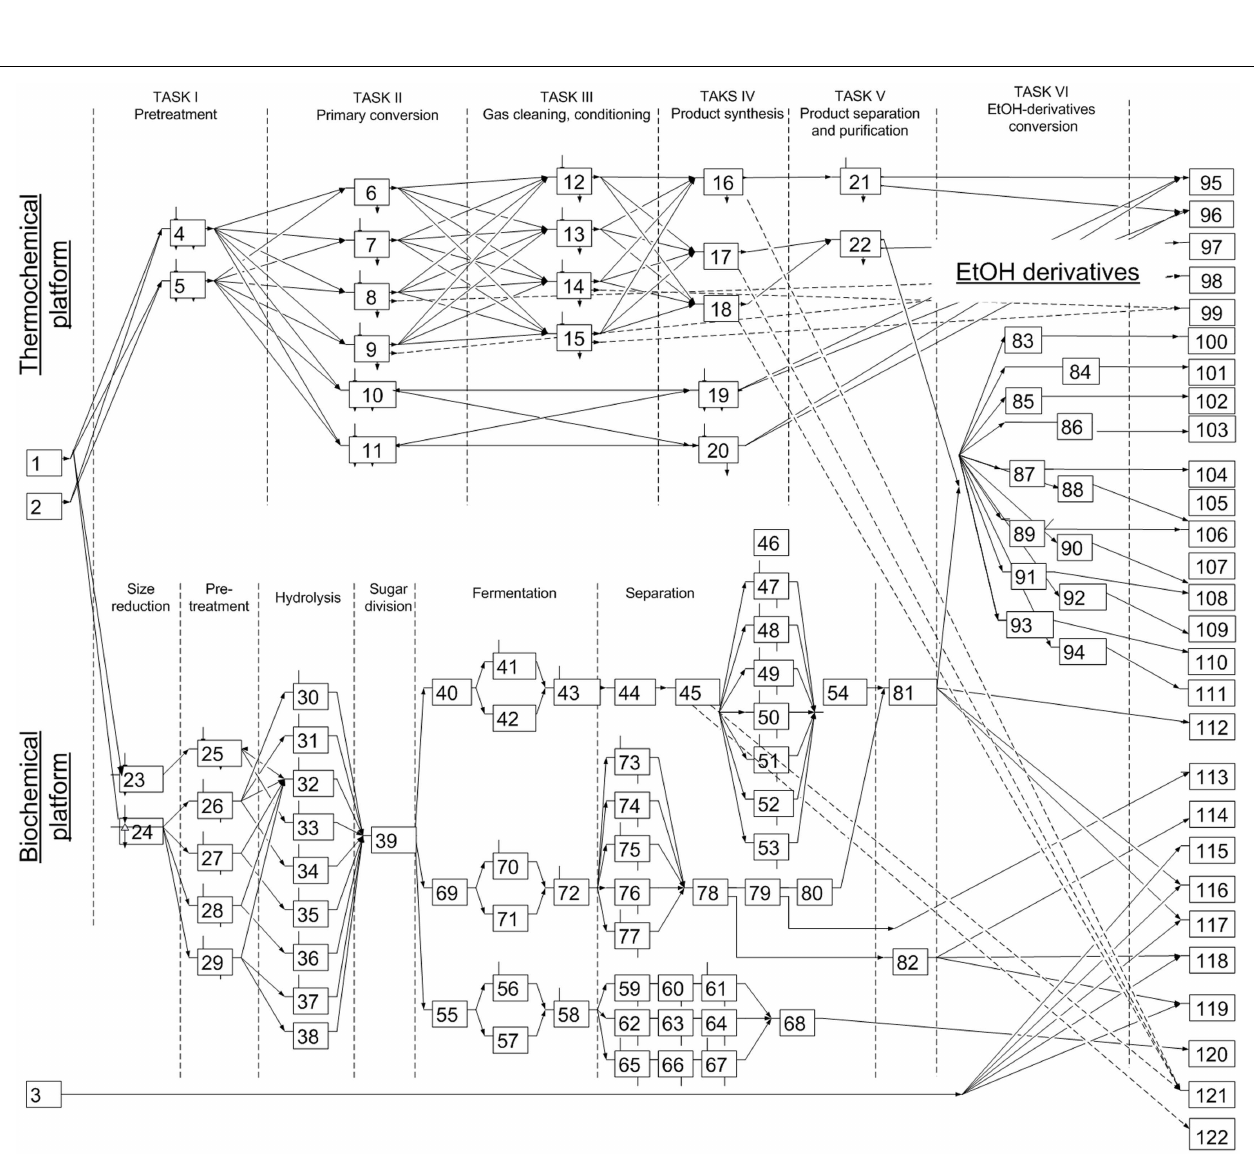
FIGURE 4 |The superstructure of the biorefinery network extended with bioethanol based derivatives . Biomass feedstock (1–2); thermochemical conversion (4–22); biochemical conversion platform (23–82); ethanol-derivatives conversion (83–94); and bioproducts (95–122; FT-products, bioethanol, ethanol-derivatives, and